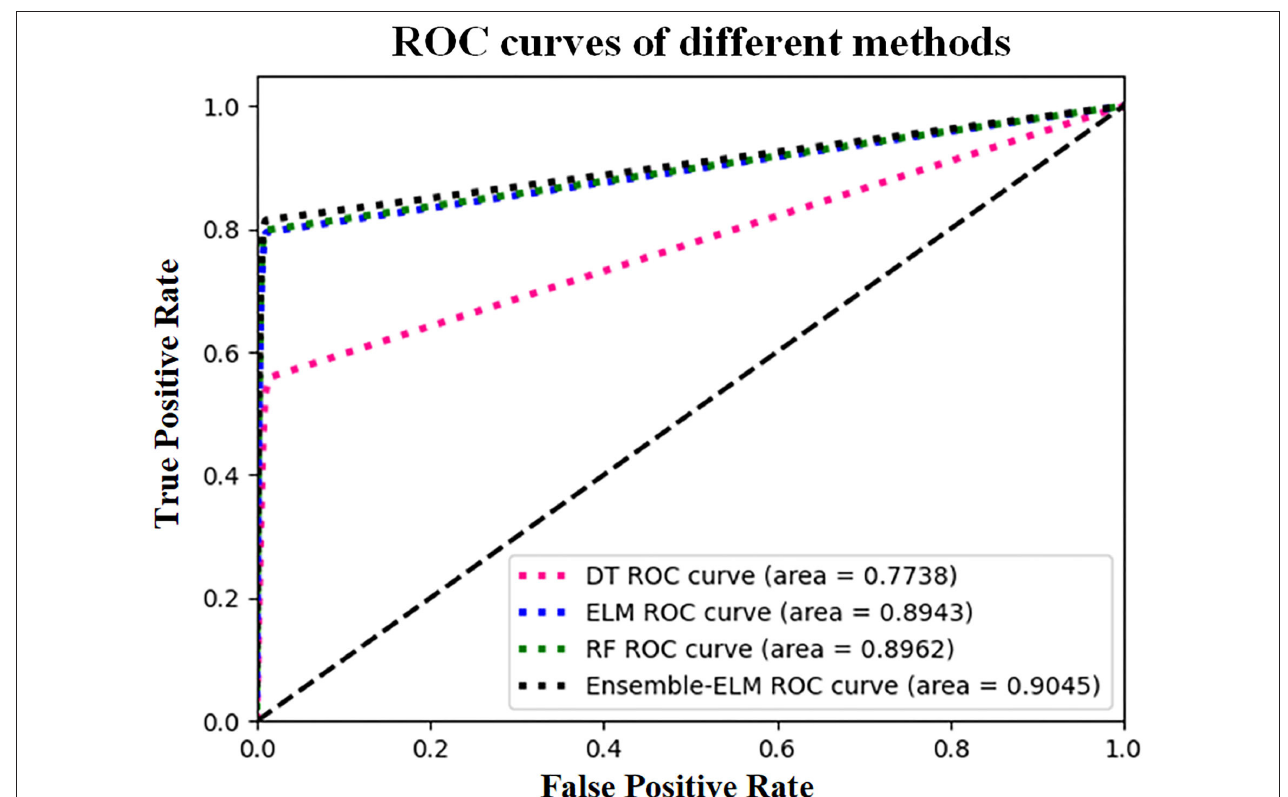
FIGURE 13 | ROC curves and AUC values of different classification